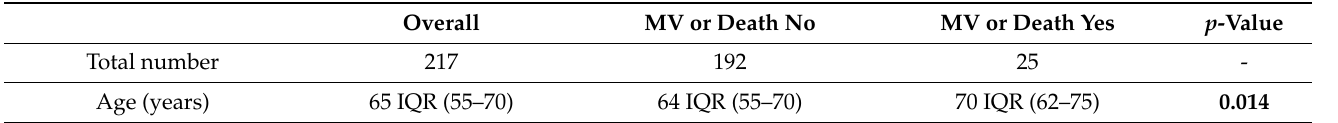
Table 1. Patient characteristics in overall cohort and stratified according to the composite outcome of mechanical ventilation or 30-day mortality. Overall MV or Death No MV or Death Yes p -Value Total